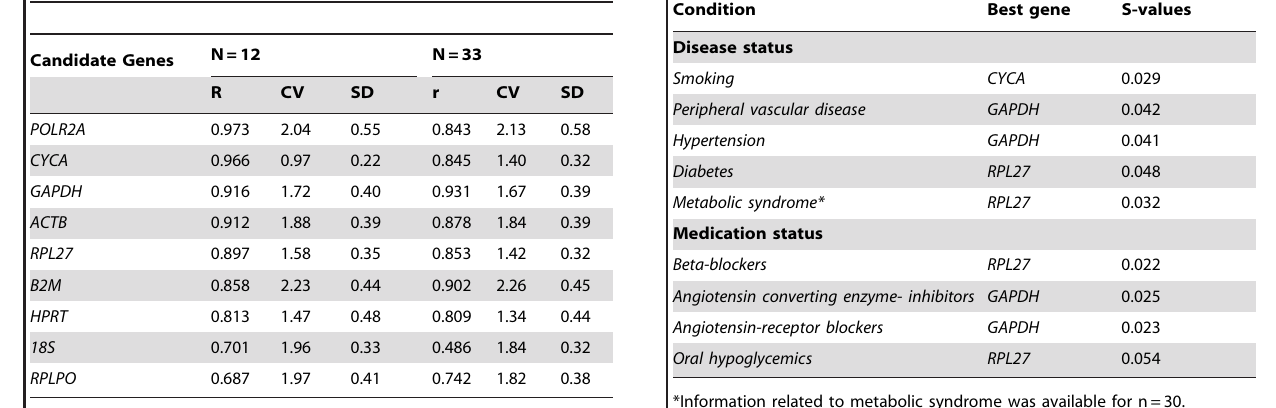
Table 4. Coefficient of correlation (r), coefficient of variation (CV) and standard deviation (SD) in the Ct values of each candidate gene calculated by the Bestkeeper algorithm for n= 12 and